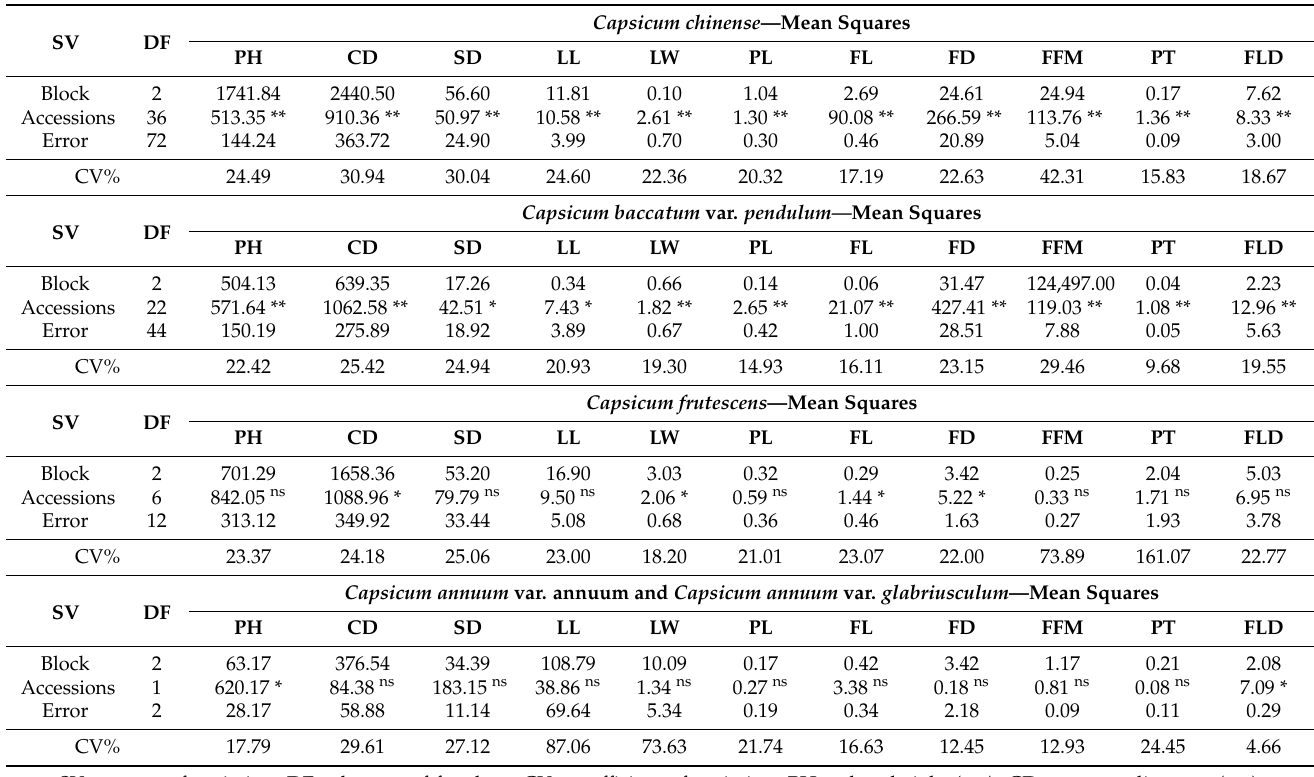
Table 1. Analysis of variance (ANOVA) of the 11 quantitative descriptors studied for each Capsicum species.